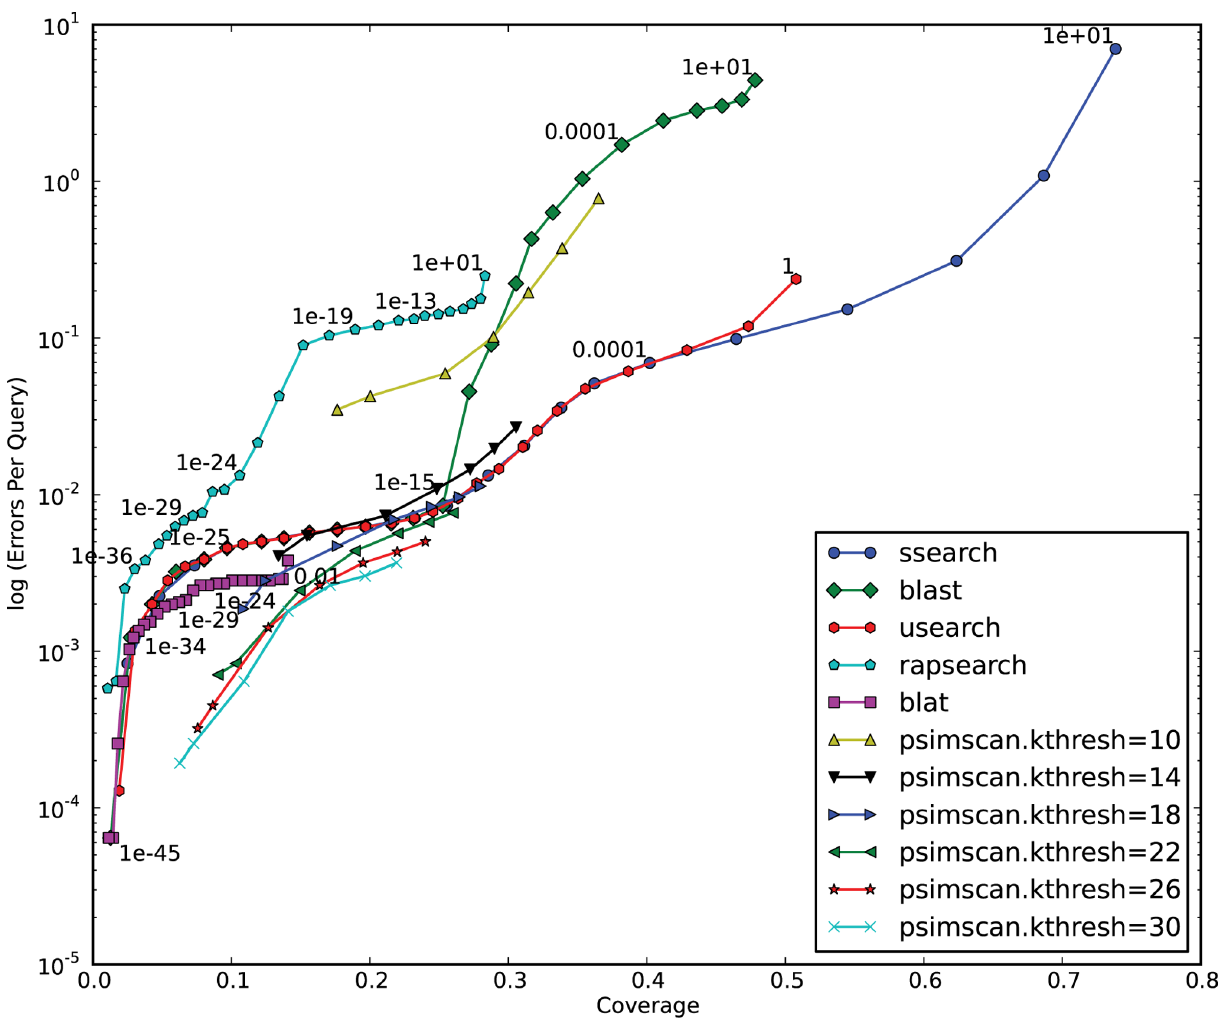
Figure 5. Selectivity and Sensitivity of PSimScan at different parameters versus other similarity search tools. All of the proteins in the PDB90 database were compared with each other using PSimScan, SSEARCH, BLAST, USEARCH, RAPSearch and BLAT. PSimScan was tested at different combinations of kthresh (similarity zone detection threshold) and approx (tuple diversification level) parameters. For SSEARCH, BLAST, USEARCH, RAPSearch and BLAT, the Coverage vs Error graphs were plotted as described by Brenner et al [47]. Similarities between proteins of the same SCOP fold were treated as true positives, while similarities between proteins of different folds – as false positives (errors). The Coverage is the ratio between the number of true positives and the total number of protein pairs, where both members belong to the same fold. The EPQ is the ratio between the number of detected false positives and the number of queries. The Coverage-vs.-Error graph contains points in the Coverage/EPQ plane which correspond to the sets of similarities with E-values below a given cut-off (some dots on the graphs are labeled with E-values). To get comparable graphs for different tools, we re-computed the E-values for all detected similarities with SSEARCH, and used those E-values for the graph construction. We ran PSimScan at all combinations of 6 different kthresh values (shown in legend) and 7 different approx values. For each run, total coverage and EPQ were computed and plotted. On each curve corresponding to a particular kthresh , the triangles mark the following approx values, left to right: 1.0, 0.95, 0.9, 0.85, 0.8, 0.76,